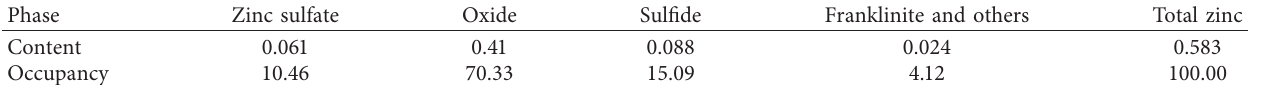
Table 4: Phase analysis results of zinc (%).